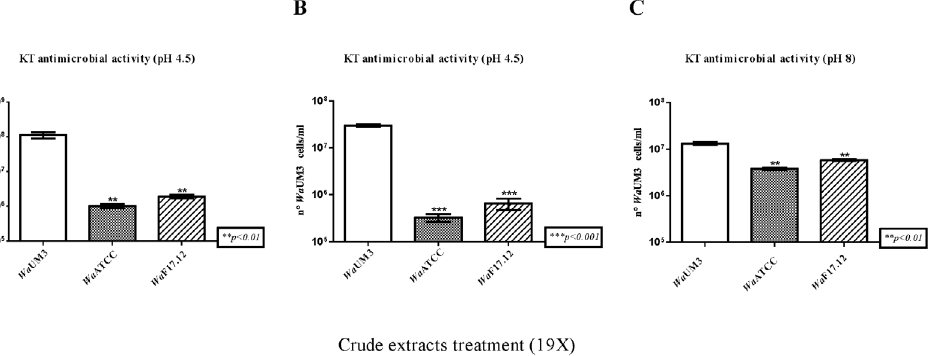
Figure 4. Crude Wa F17.12-KT extract activity assays. The susceptible strains Ca ATCC 24433 (A) and Wa UM3 (B and C) were incubated for 12 h at 26 u C at pH 4.5 (A and B) and 8 (C) with Wa KT crude extracts (19X) from Wa F17.12, Wa ATCC 96603 ( Wa KT-producing strain) or Wa UM3 ( Wa KT non- producing strain). Crude Wa KT activity was evaluated using the trypan blue test reporting the number of vital cells/ml of the two target strains and the values are reported as mean 6 SEM (n=6). Asterisks refers to the statistical significance of the differences, according to the One Way ANOVA and Bonferroni’s Multiple Comparation Tests.